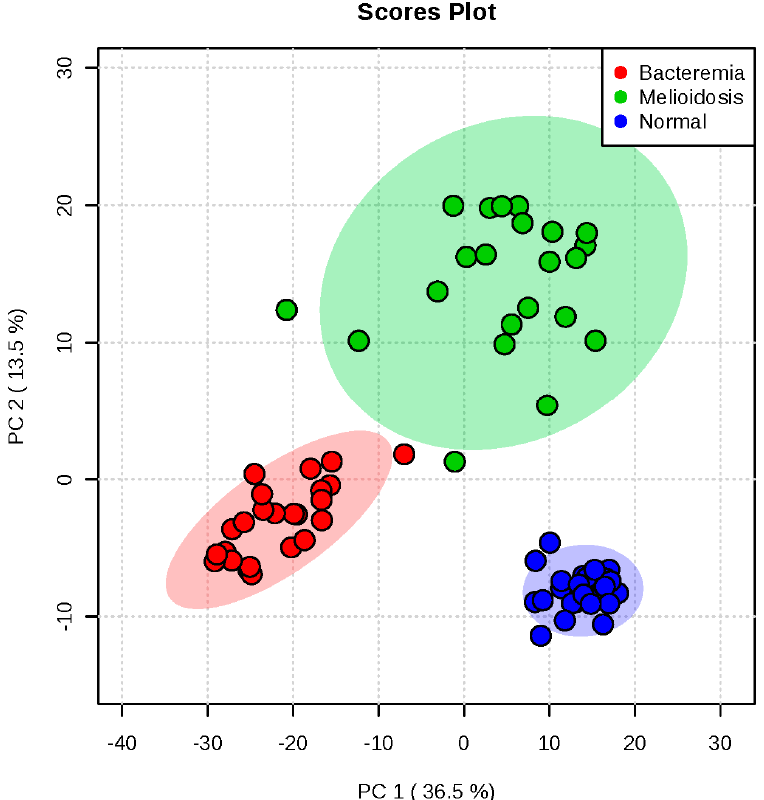
Figure 1. Principal component analysis (PCA) score plot in positive mode based on human plasma of 22 melioidosis, 24 bacteremia and 30 controls without active infection. The PCA score plots showed that samples from melioidosis patients, bacteremia patients and controls without active infection were clustered separately.